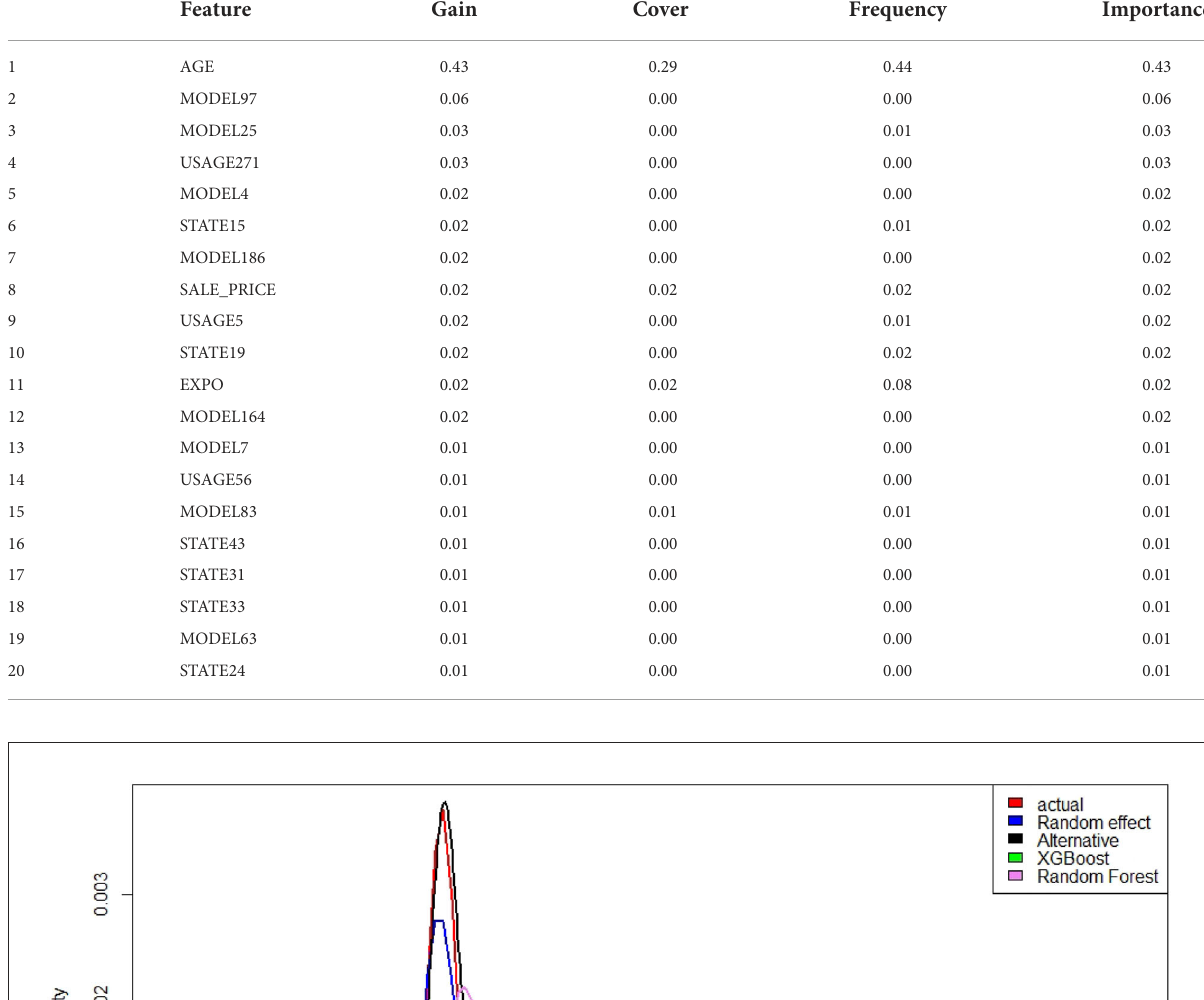
TABLE 11 Variable importance for the XGboost model.